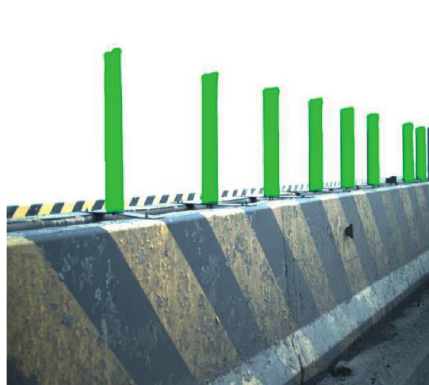
Figure 2: Segmentation result of anti-glare panel based on PointRend.